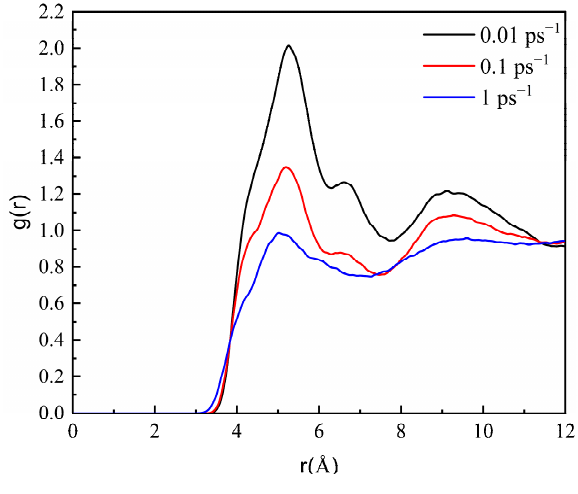
Figure 14. RDF of C 38 at 283.15 K.